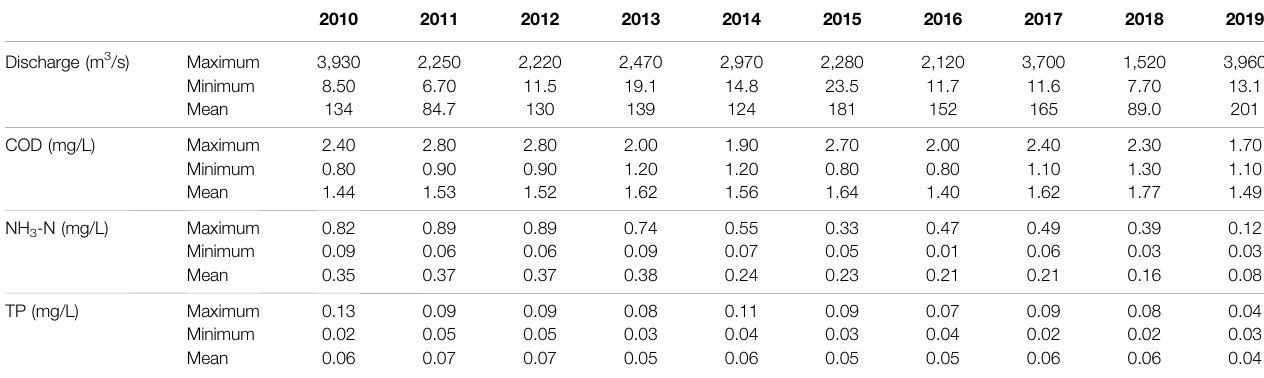
TABLE 2 | Statistics of discharge, chemical oxygen demand (COD), ammonia nitrogen (NH 3 -N), and total phosphorus (TP)